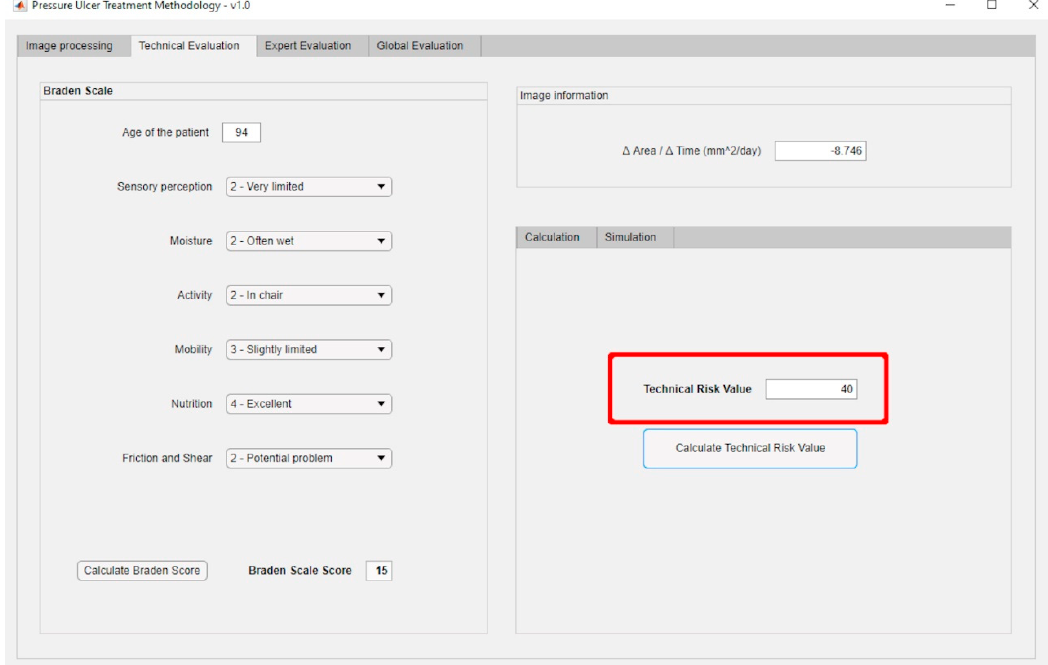
Figure 21. Technical evaluation panel.